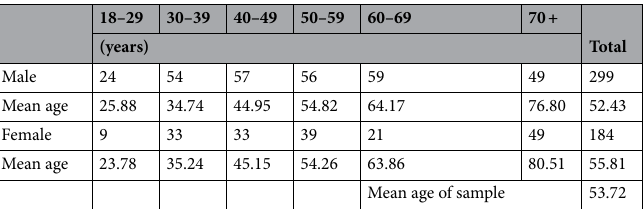
Table 2. Age distribution of the sample; numbers of pelvic bones in each age category.